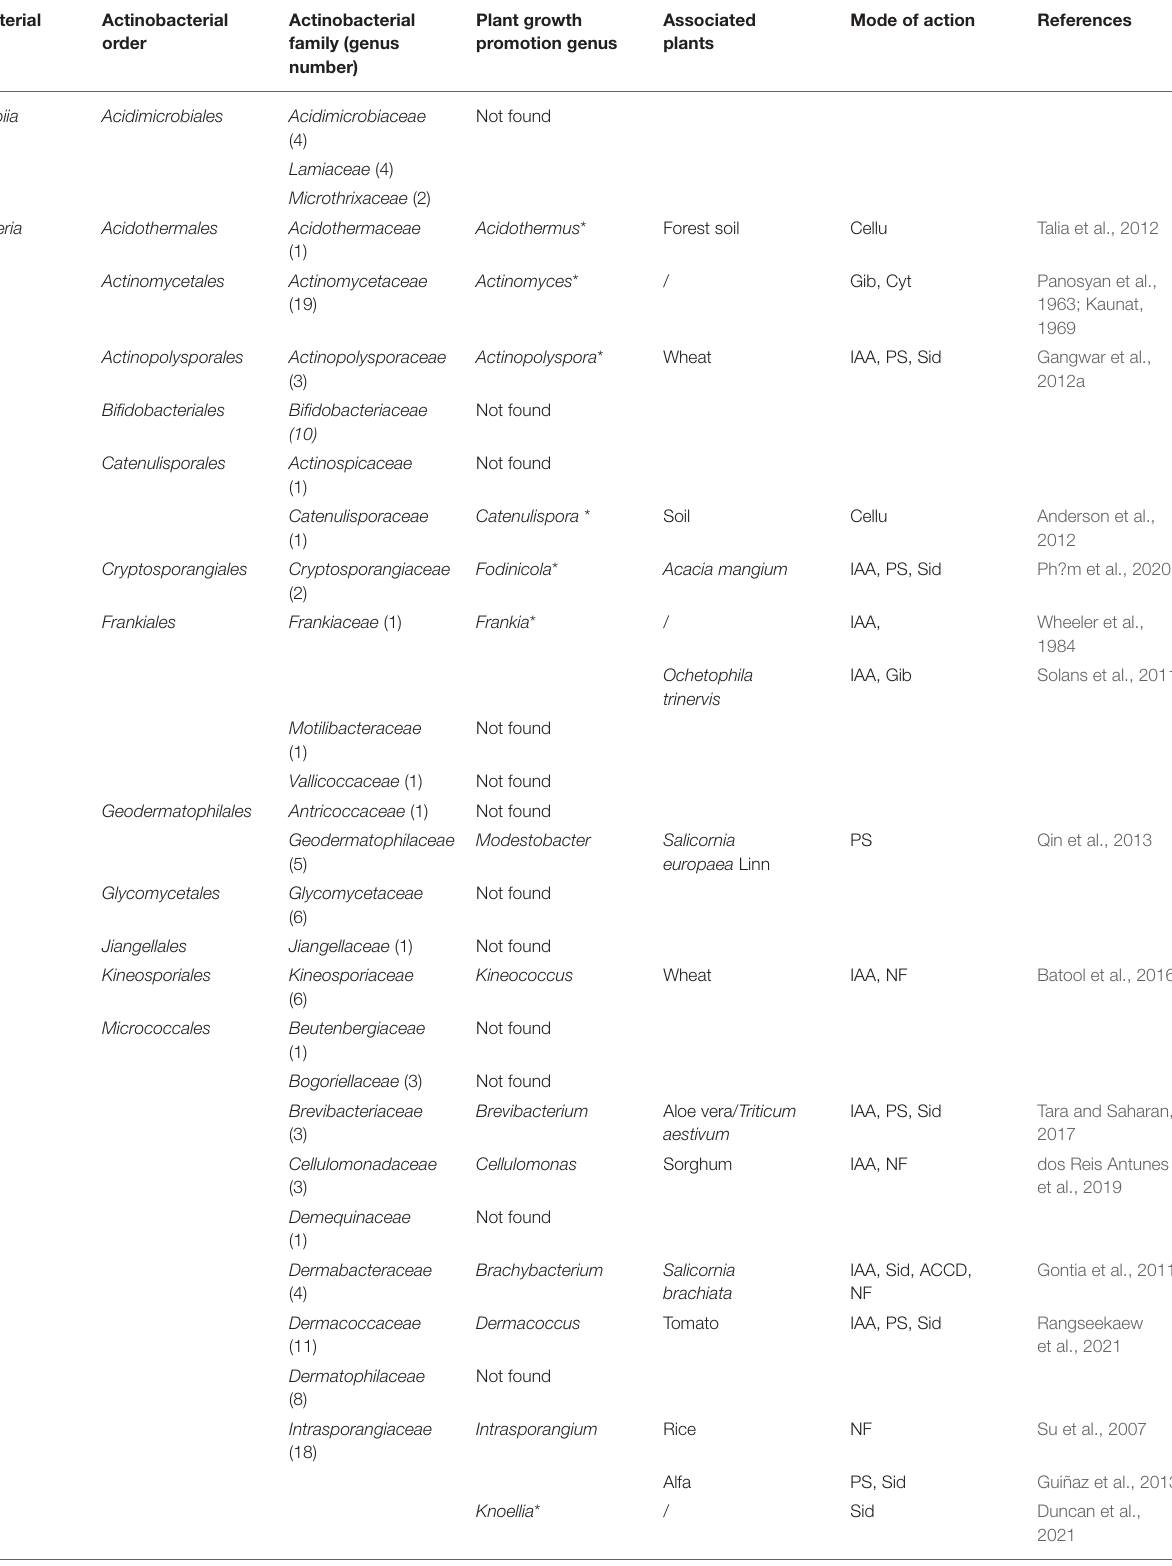
TABLE 1 | Distribution of some PGP traits among Actinobacteria